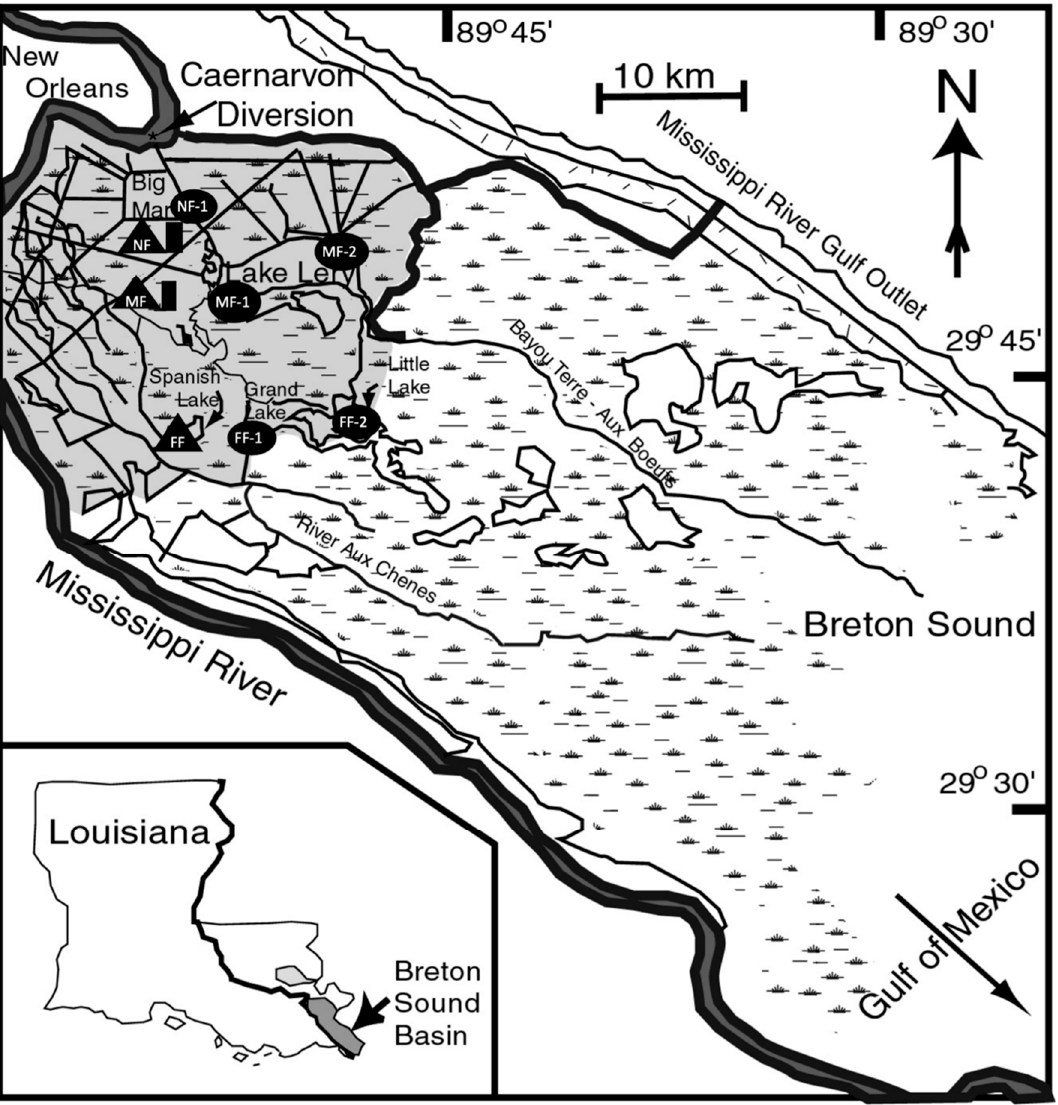
Figure 2. Location of stations used to measure benthic fluxes in subtidal and marsh environments. Subtidal benthic stations ( ● ) are located in Big Mar, Lake Leary (west and east), and Grand Lake. Marsh fluxes include both flumes ( ▪ ) and chambers ( (cid:78) ) located at Big Mar, at the Delacroix Camp, and downstream at Spanish Lake (core fluxes only). Shaded area is the outfall region of upper Breton Sound that was distributed among near-, mid-, and far-field zones.